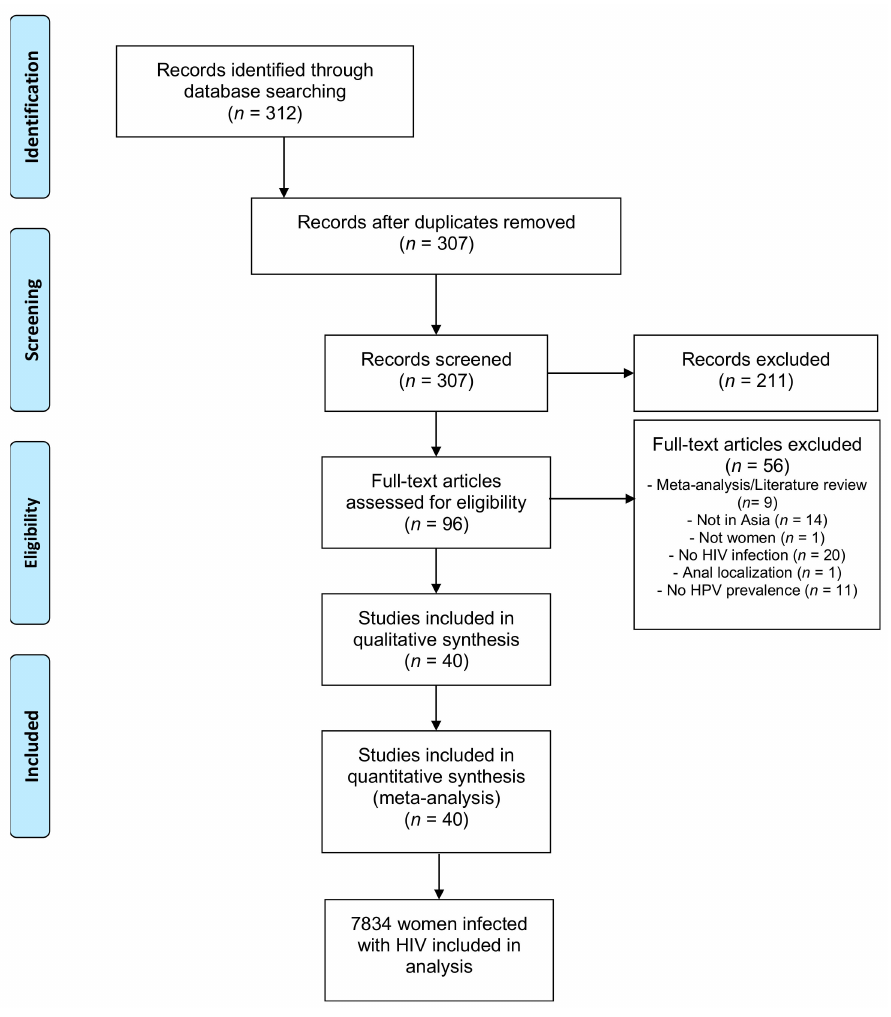
Figure 1. Process of selecting studies used in the